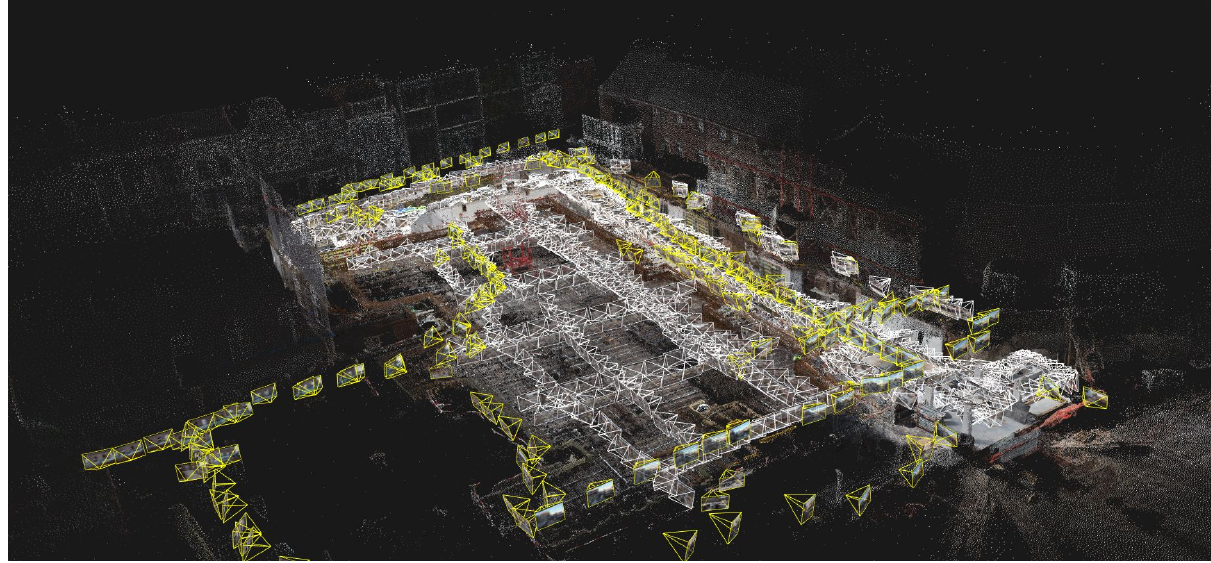
Figure 1: The yellow pictures form part of the geo-registered reference dataset, serving as the basis for the registration of the newly captured white pictures. Although the recordings of the new dataset mainly focus on the construction site itself, the surroundings are clearly depicted by the vertices originating solely from the new dataset (i.e. the white